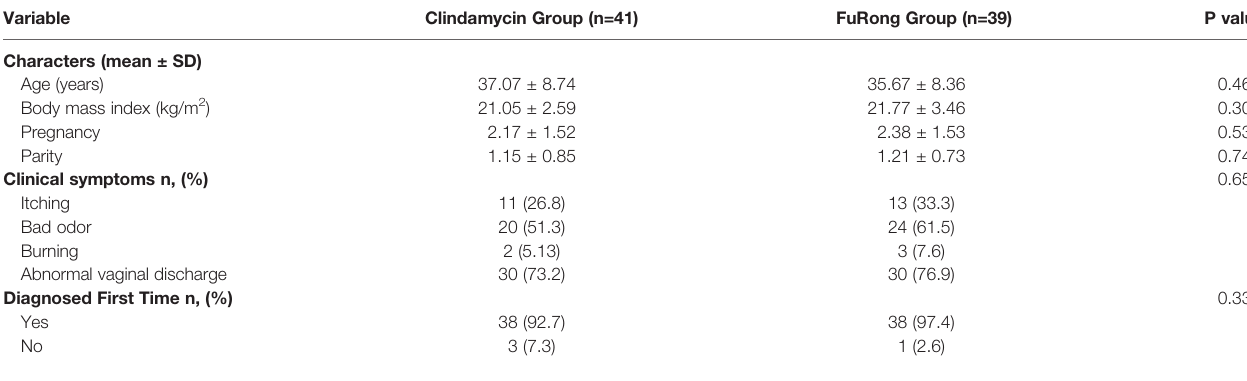
TABLE 2 | Sample characteristics and vaginal clinical symptoms at the baseline.